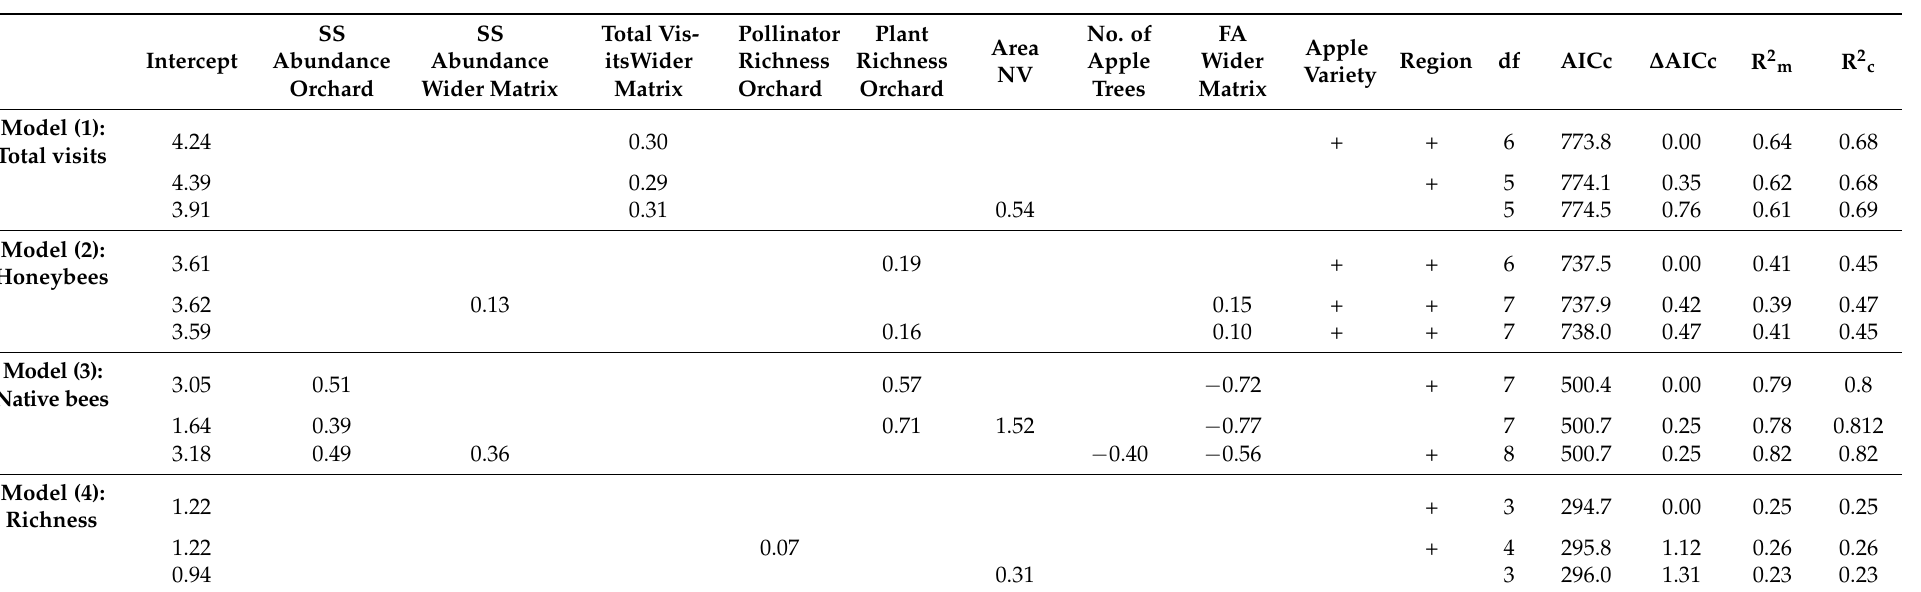
Table 3. The three best fitting models (with ∆ AICc < 2) describing the number and species richness of pollinator visits to apples and co-flowering species within the orchard and the wider matrix. Model (1), total visitation by insect visitors to apple flowers; Model (2), honeybee visitation to apple flowers; Model (3) native-bee visitation to apple flowers; and Model (4), flower visitor richness to apple flowers. Only variables retained in the best fitting models are displayed in the table. The Models (1)–(3) were analyzed by using Generalized Linear Mixed Models with negative binomial distribution, and Model (4) was analyzed with a Poisson distribution. The overall model fit (R 2 ) is divided into marginal R 2 (R 2 m ) and conditional R 2 (R 2 c )